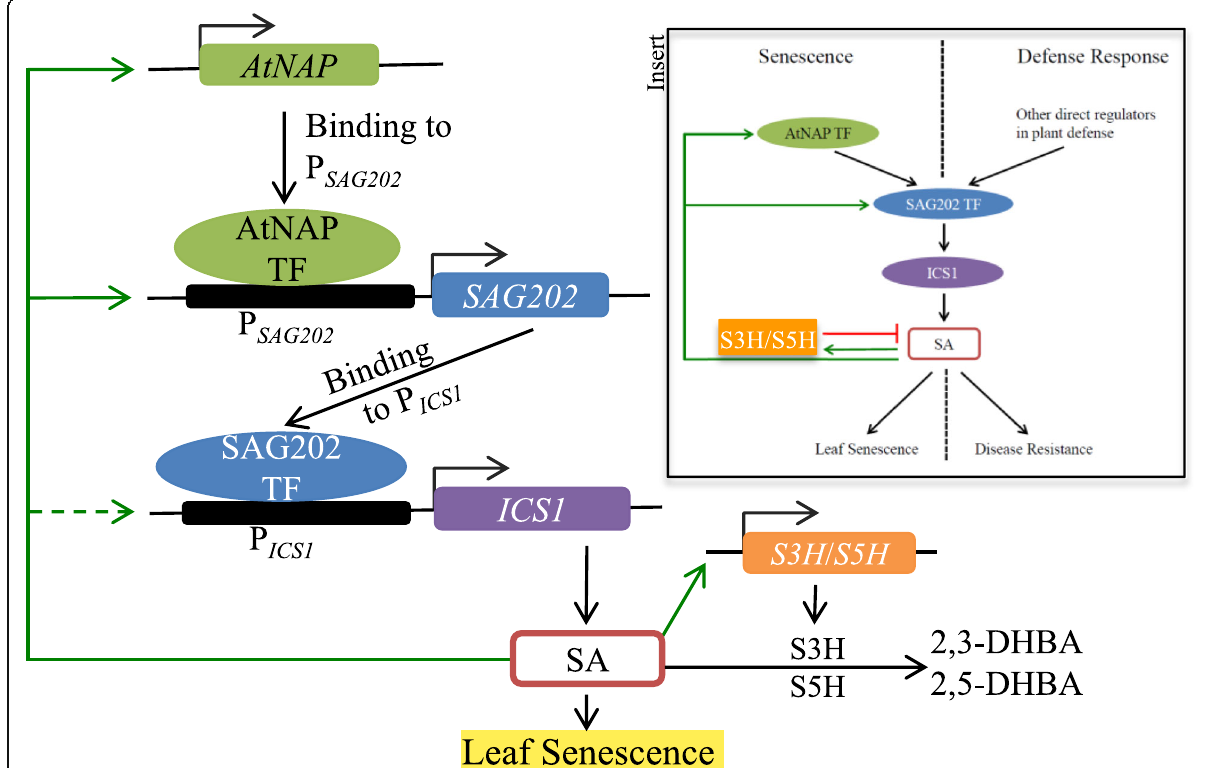
Fig. 8 A working model of SA- AtNAP - SAG202 - ICS1 -SA positive feedback loop in leaf senescence and its convergence/divergence in defense response in Arabidopsis. At the onset of and during leaf senescence, AtNAP TF physically binds to the promoter of SAG202 to direct the target gene expression. Subsequently the SAG202 TF activates its direct target gene ICS1 that is involved in the SA biosynthesis. The produced SA in turn feedback upregulates both AtNAP and SAG202 . When the SA levels increase to a threshold, S3H (encoding an SA 3-hydroxylase) and S5H is induced to prevent overaccumulation of SA (Zhang et al., 2013; Zhang et al., 2017b). Too high levels of SA will cause hypersensitive response (HR)-like fast cell death. Leaf senescence is a slow programmed cell death process to allow nutrients released from degradation of proteins and other macromolecules to be recycled to active growing region or storage organs. Insert : A diagram showing convergence and divergence between leaf senescence and defense response with regard to the newly uncovered SA- AtNAP - SAG202 - ICS1 -SA regulatory loop. SA- AtNAP - SAG202 - ICS1 -SA feedback loop is activated to modulate endogenous SA levels in leaf senescence but not in defense responses. In defense response part of the loop, SAG202 - ICS1 -SA is DNA insertion